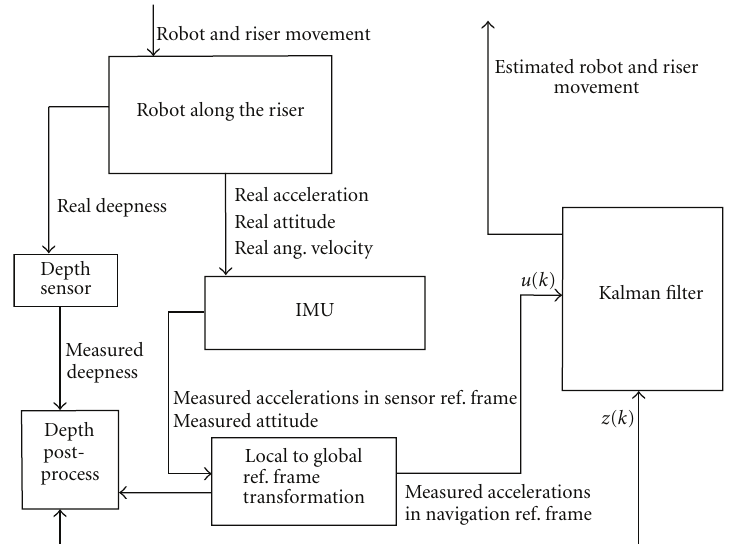
Figure 4: Architecture of the proposed localization system architecture. The robot scrolling along the riser generates a set of kinematic variables that is measured by the IMU. The accelerations are transformed to the global reference system, using IMU attitude outputs, and considered as the inputs of the KF. To compensate the drift caused by integrated sensor noise, the KF fuses the IMU with depth sensor data, that is, an absolute measurement. Before entering in the KF, the external measurements are processed by the method described in Section 6, using IMU attitude